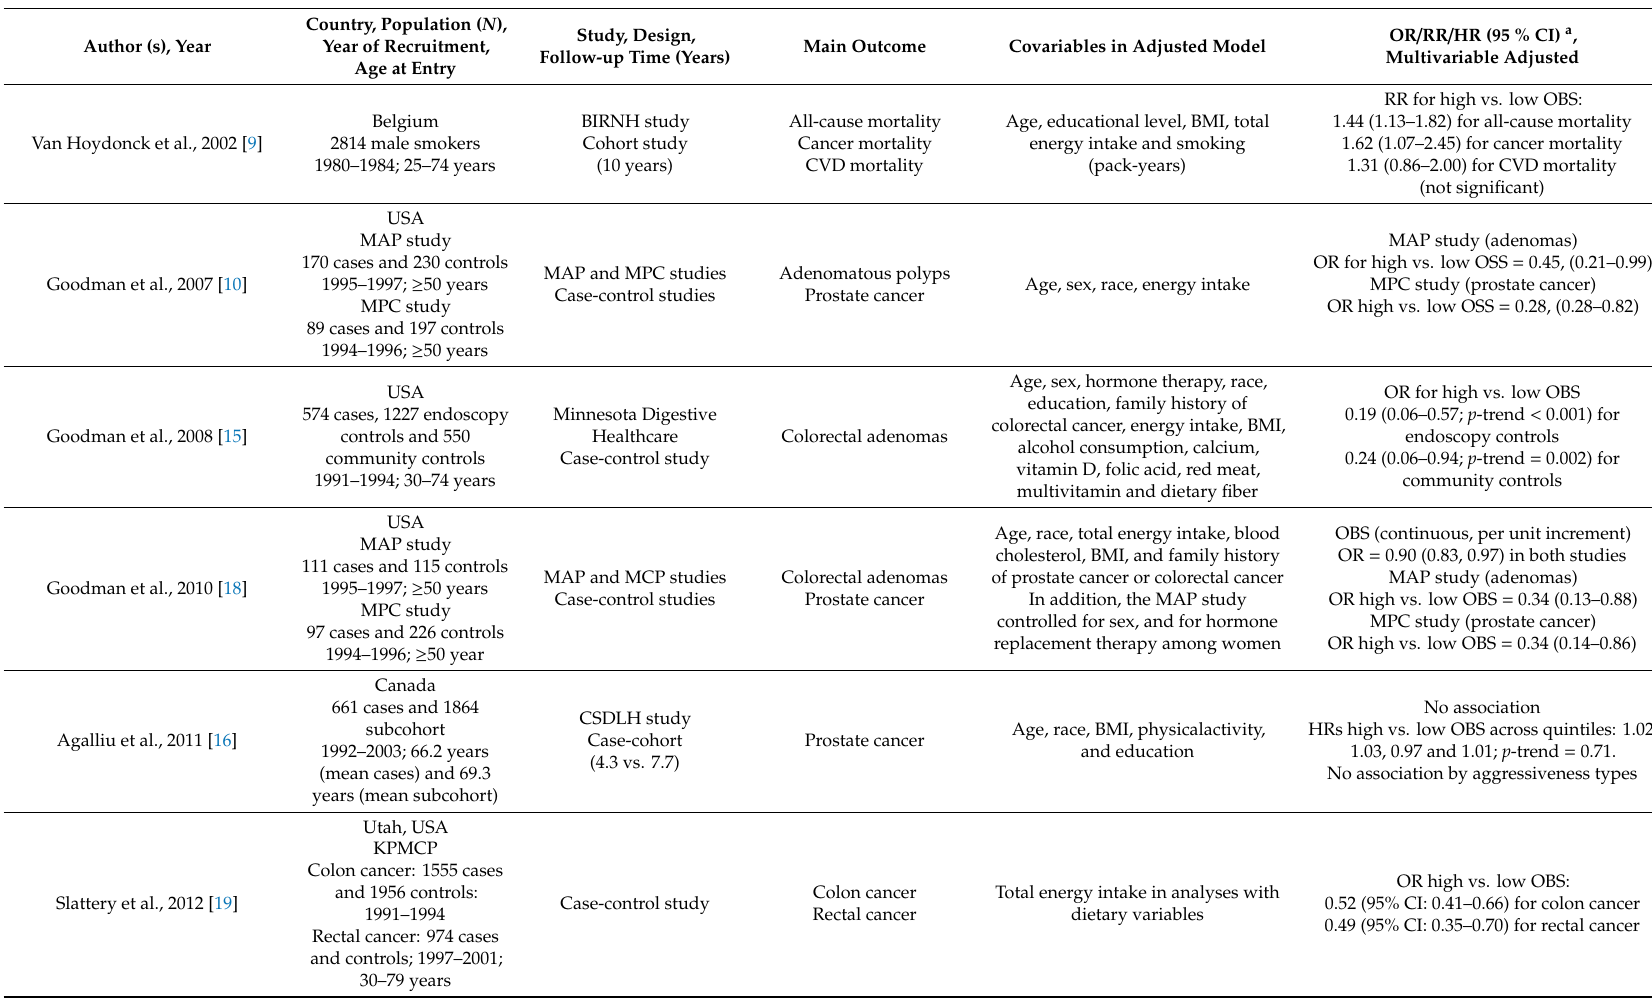
Table 8. Main characteristics of studies analyzing the association between a priori Oxidative Balance Scores and health